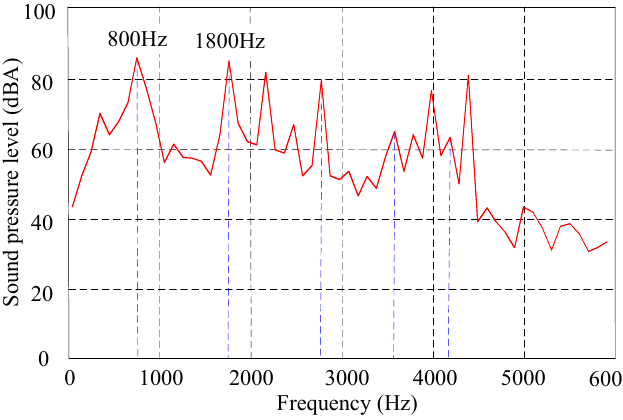
Figure 8. Noise spectrum under rated load.